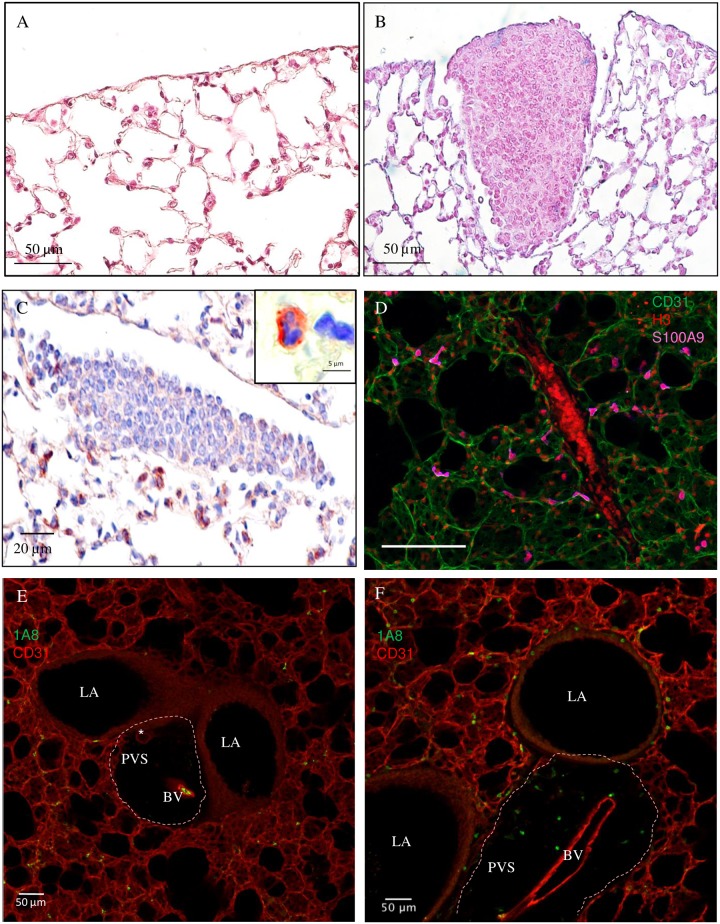
Granulomas and neutrophil-infiltrated peri-vascular space in the lung of infected mice.BALB/c mice were inoculated with 40 L3 of L. sigmodontis either subcutaneously (SC) or intravenously (IV). After two hours (h2) six hours (h6), two days (d2), four days (d4) and 8 days (d8) post inoculation, lung sections were prepared. (A) Haematoxylin-Eosin staining of a naïve lung section showing normal parenchyma and mesothelium. (B) Haematoxylin-Eosin staining of a lung section showing a granuloma in SC-infected mice at d8 p.i. (C) Ly6G/C (clone NIMPR-R14) immunostaining of lung sections at d8 p.i. (from a SC-infected mouse) were performed showing absence of neutrophils within the granuloma but presence in the surrounding tissue. Neutrophils were differentiated from monocytes by their nuclei shapes (cf corner zoom) (D) Representative maximum intensity projection from a confocal z-stack of S100A9 (an abundant neutrophil protein, magenta) immunostaining of lung precision cut lung slices (PCLS) at d8 p.i. (IV-infected mouse) showing absence of neutrophils within the granuloma but presence in the surrounding tissue; CD31 (green) stain for endothelial cells and histone H3 (red) for cells. (E-F) Representative maximum intensity projection from a confocal z-stack of a lung PCLS with CD31+ capillaries (red) surrounding larger airways (LA) and a peri-vascular space (PVS) (the boundaries of which are marked by dashed line) containing a blood vessel (BV) and a lymphatic vessel (*) with (E) the absence of Ly6G+ (clone 1A8) neutrophils (green) in the PVS of naïve mouse; and (F) the presence of Ly6G+ neutrophilic infiltrates in the PVS and around airways in a d4 IV-infected mouse.